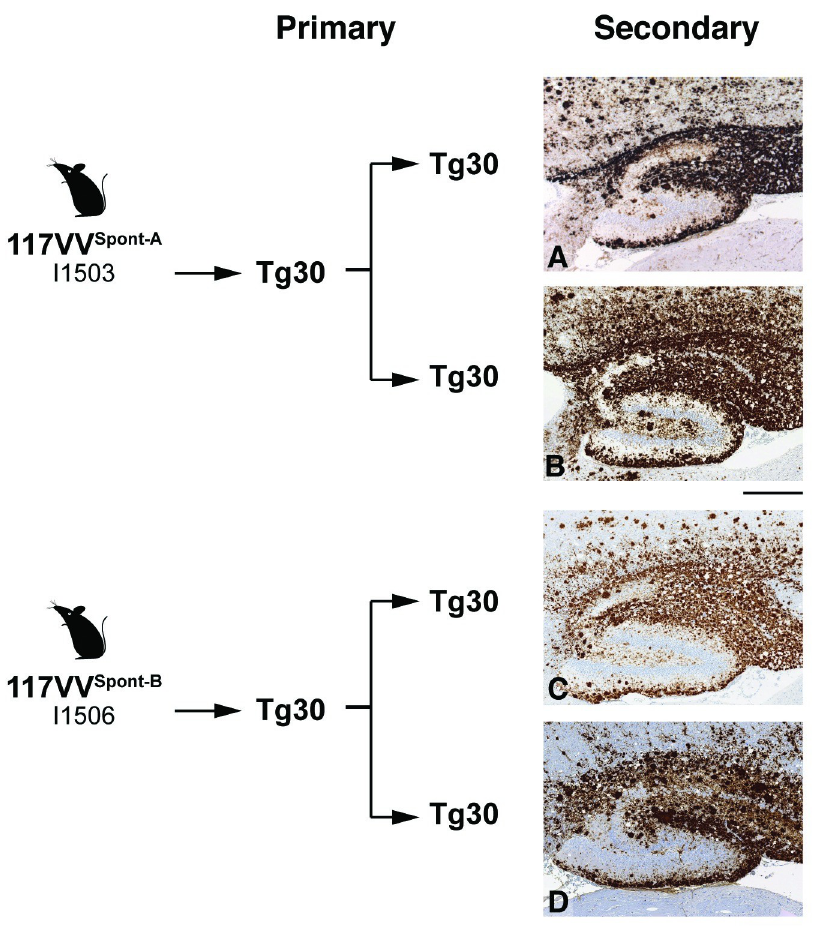
Fig 6. Immunohistochemical analyses of brain from 117VV Tg30 mice challenged with spontaneous 117V prion isolates passaged once in 117VV Tg30 mice. IHC was performed using anti-PrP monoclonal antibody ICSM 35 (epitope human PrP residues 93–105). Panels A–D show the hippocampus. (A, B) Spontaneous 117V prion isolate from 117V Spont-A mouse brain was passaged once in 117VV Tg30 mice and then passaged in further 117VV Tg30 mice. (C, D) Spontaneous 117V prion isolate from 117V Spont-B mouse brain was passaged once in 117VV Tg30 mice and then passaged in further 117VV Tg30 mice. Mice in panels A–D were culled without neurological disease at 455, 457, 417, and 456 days post-inoculation, respectively. Scale bar, 300 μ m. ICSM, Imperial College School of Medicine; IHC, immunohistochemistry; PrP, prion protein. Our finding that spontaneous 117V prion isolates once amplified in 117VV Tg30 mice can convert wild-type human PrP 129V to a protease-resistant form suggests that the pathological involvement of wild-type PrP may be an important modifier of disease pathogenesis in IPD A117V patients. Given the profound effect that codon 129 mismatch in wild-type PrP has in controlling disease pathogenesis in sporadic and acquired CJD (where heterozygosity at codon 129 is thought to confer resistance to prion disease by inhibiting homologous protein-protein interactions [71,74–76] and the presence of 129M or 129V controls the propagation of distinct human prion strains via conformational selection [2,9,15,18–20]), we looked for similar effects in IPD A117V patients. In keeping with similar findings with IPD associated with an insertion of 4, 5, or 6 extra octapeptide repeats [77–79], or in a pedigree of IPD P102L [40,80], we found that the age of onset of disease in IPD A117V patients whose wild-type PrP codon 129 geno- type matched that of the mutant 117V PrP (129V) was significantly shorter than in codon 129